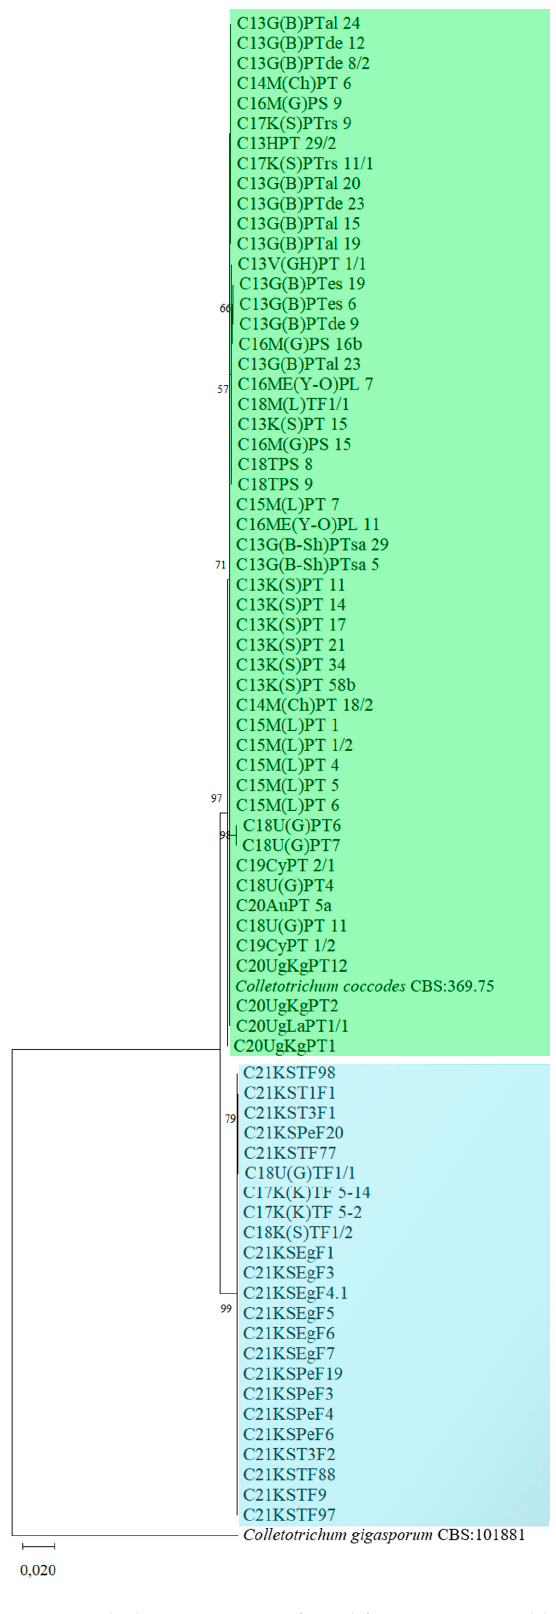
Figure 2. Phylogenetic tree inferred from maximum-likelihood analysis of the concatenated align- ment, including the ITS region, and the partial act , gaphd , and gs gene regions. The confidence values are indicated at the branches. Green indicates C. coccodes clade, and blue indicates the C. nigrum clade.